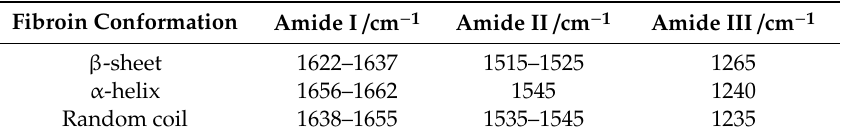
Table 2. Infrared absorptions of silk fibroin